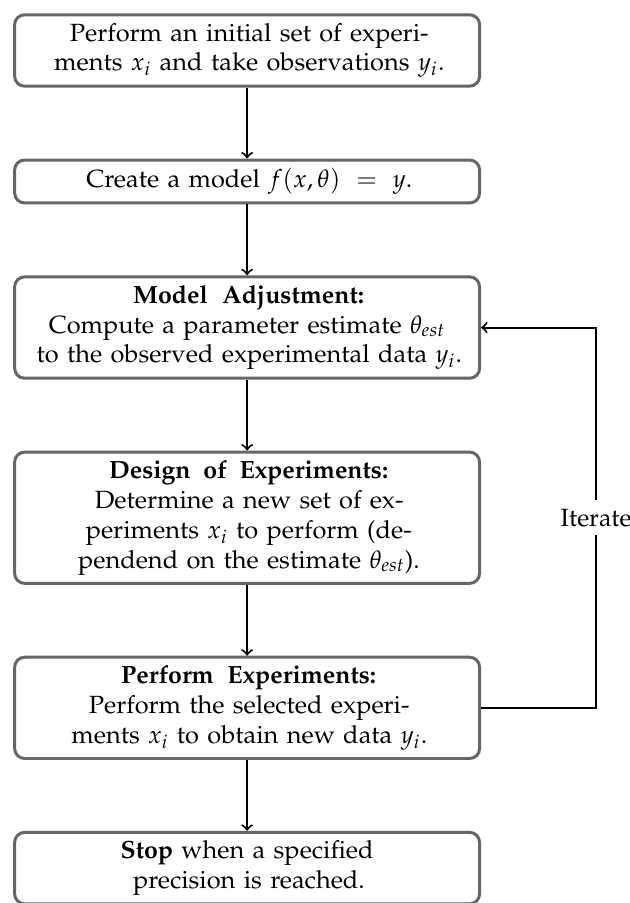
Figure 1. Iterative model identification workflow to improve parameter